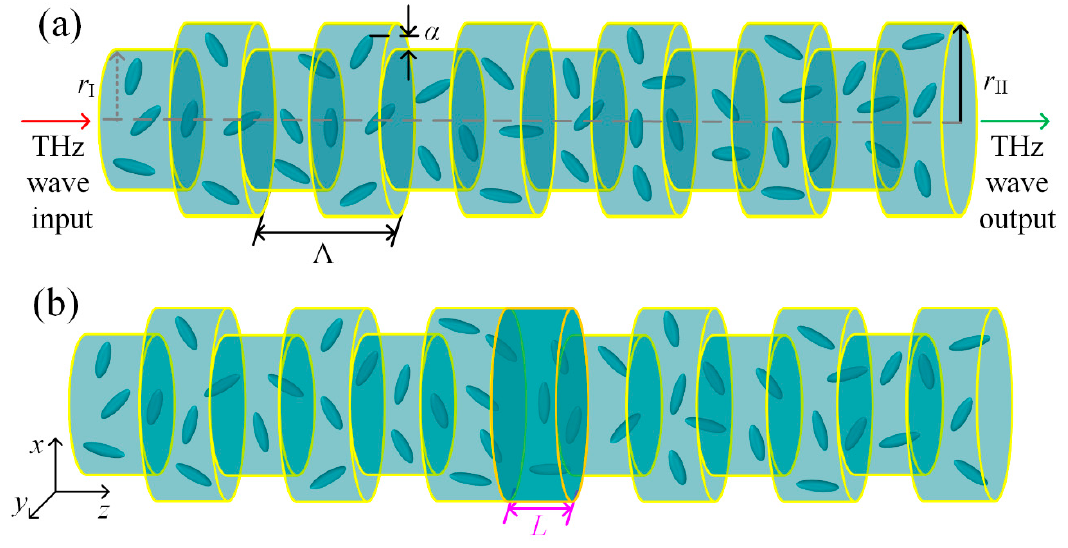
red solid lines, respectively. It is obvious that a forbidden band (the pink shadow) appears around 1 THz and the red solid lines as the references also intersect at 1 THz.